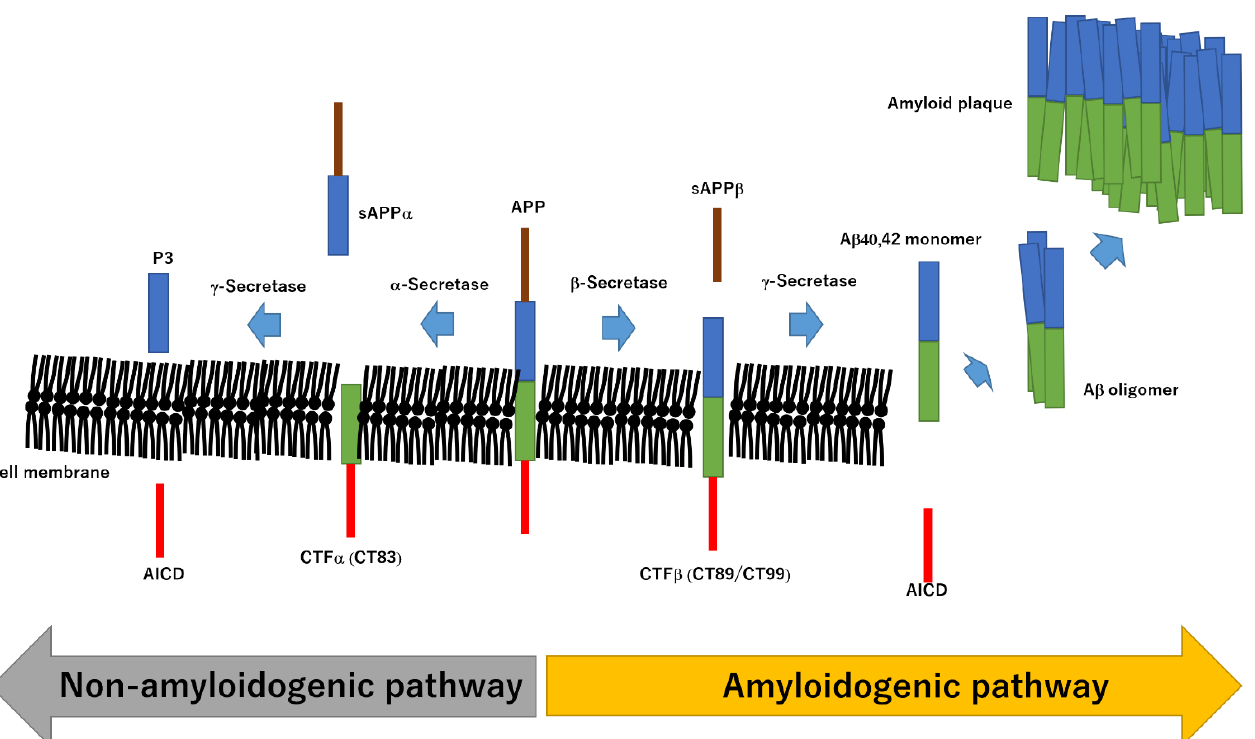
Figure 1. Amyloidogenic pathway and non-amyloidogenic pathway. sAPP—soluble amyloid precursor protein, Aβ — amyloid β, AICD —APP intercellular domain, CTF—C-terminal fragment, cursor protein, A β —amyloid β , AICD—APP intercellular domain, CTF—C-terminal fragment, P3—P3 peptide. P3—P3